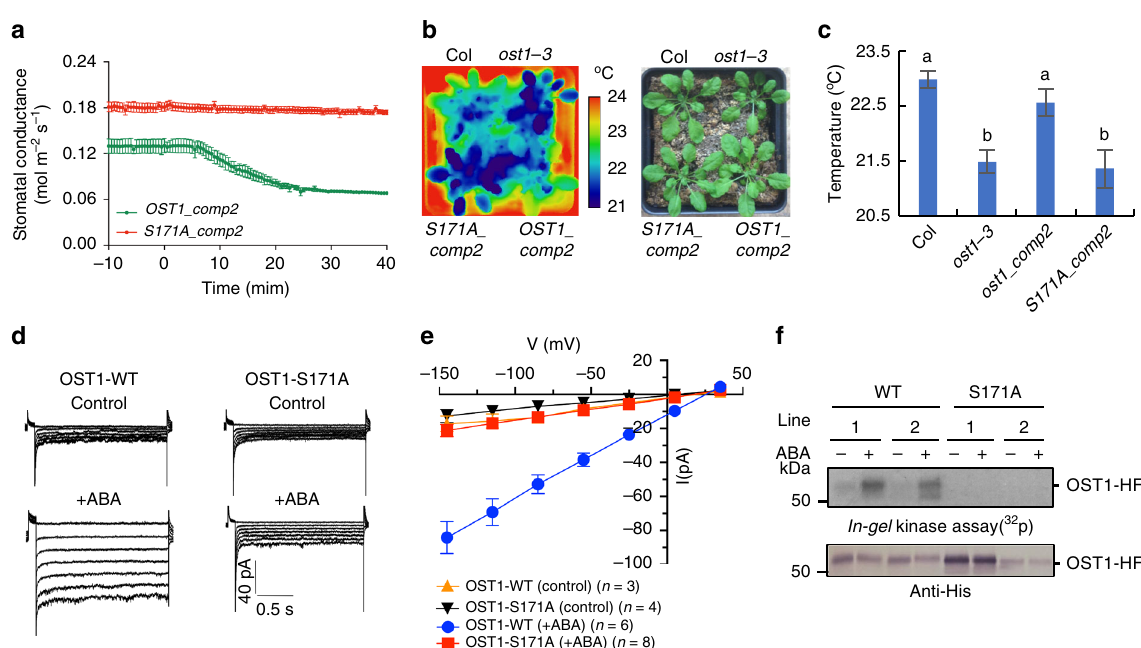
Fig. 3 OST1/SnRK2.6 Ser171 is essential for ABA-induced stomatal closure and S-type anion channel activation in planta . a Stomatal conductances were analyzed in intact detached leaves of stable transgenic Arabidopsis [ pUBQ10:OST1-HF/ost1-3 ( OST1-comp2 ) and pUBQ10:OST1-S171A-HF/ost1-3 ( S171A- comp2 )]. 2 μ M ABA was applied to petioles at 0 min. Data presented are means ± s.e.m. ( n = 4 leaves from four plants for each genotype). b Leaf temperatures of Col, ost1-3 , OST1-comp2 and S171A-comp2 were measured by thermal imaging. Plants were sprayed with 20 µ M ABA, and thermal images were taken after 3 h. The bright fi eld image shows where leaves from neighboring plants overlapped. c , Leaf temperatures were measured by using Fiji software ( n = 5 experiments, means ± s.e.m.). Letters at the top of columns are grouped based on one-way ANOVA and Tukey ’ s test, P < 0.05. d ABA- activated S-type anion channel currents were investigated by patch-clamp analyses using guard cell protoplasts from the transgenic Arabidopsis lines pUBQ10:OST1-HF/ost1-3 ( OST1-WT ) and pUBQ10:OST1-S171A-HF/ost1-3 ( OST1-S171A ). e Average current-voltage relationship of S-type anion channel as shown in d . Data presented are means ± s.e.m. f Kinase activities of OST1(S171A) in mesophyll cells from stably-transformed homozygous transgenic plants were investigated by in-gel kinase assays. Protoplasts were incubated with 10 µ M ABA for 15 (S171A) disrupted reconstitution of SLAC1 activation (Supple-